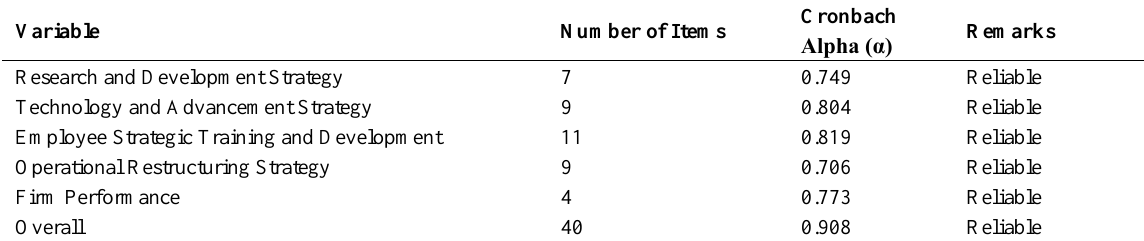
Table 1: Reliability Test of the Main Study